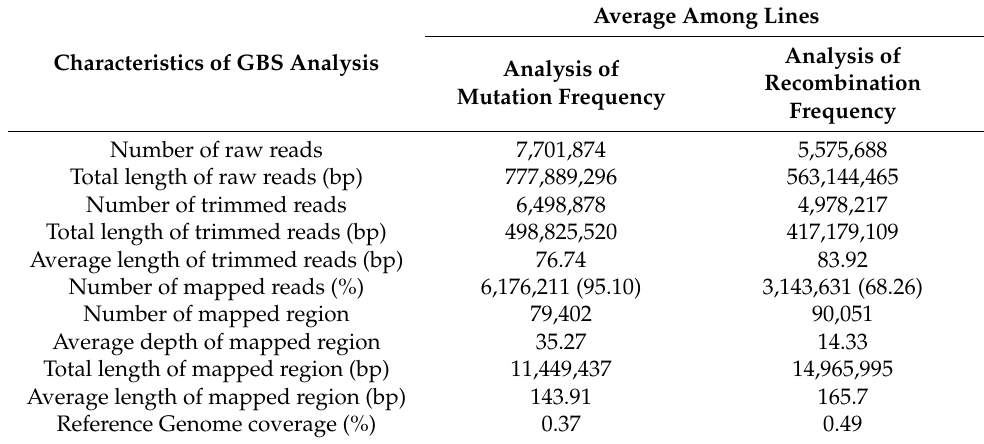
Table 1. Statistics for the genotype-by-sequencing (GBS) analysis.